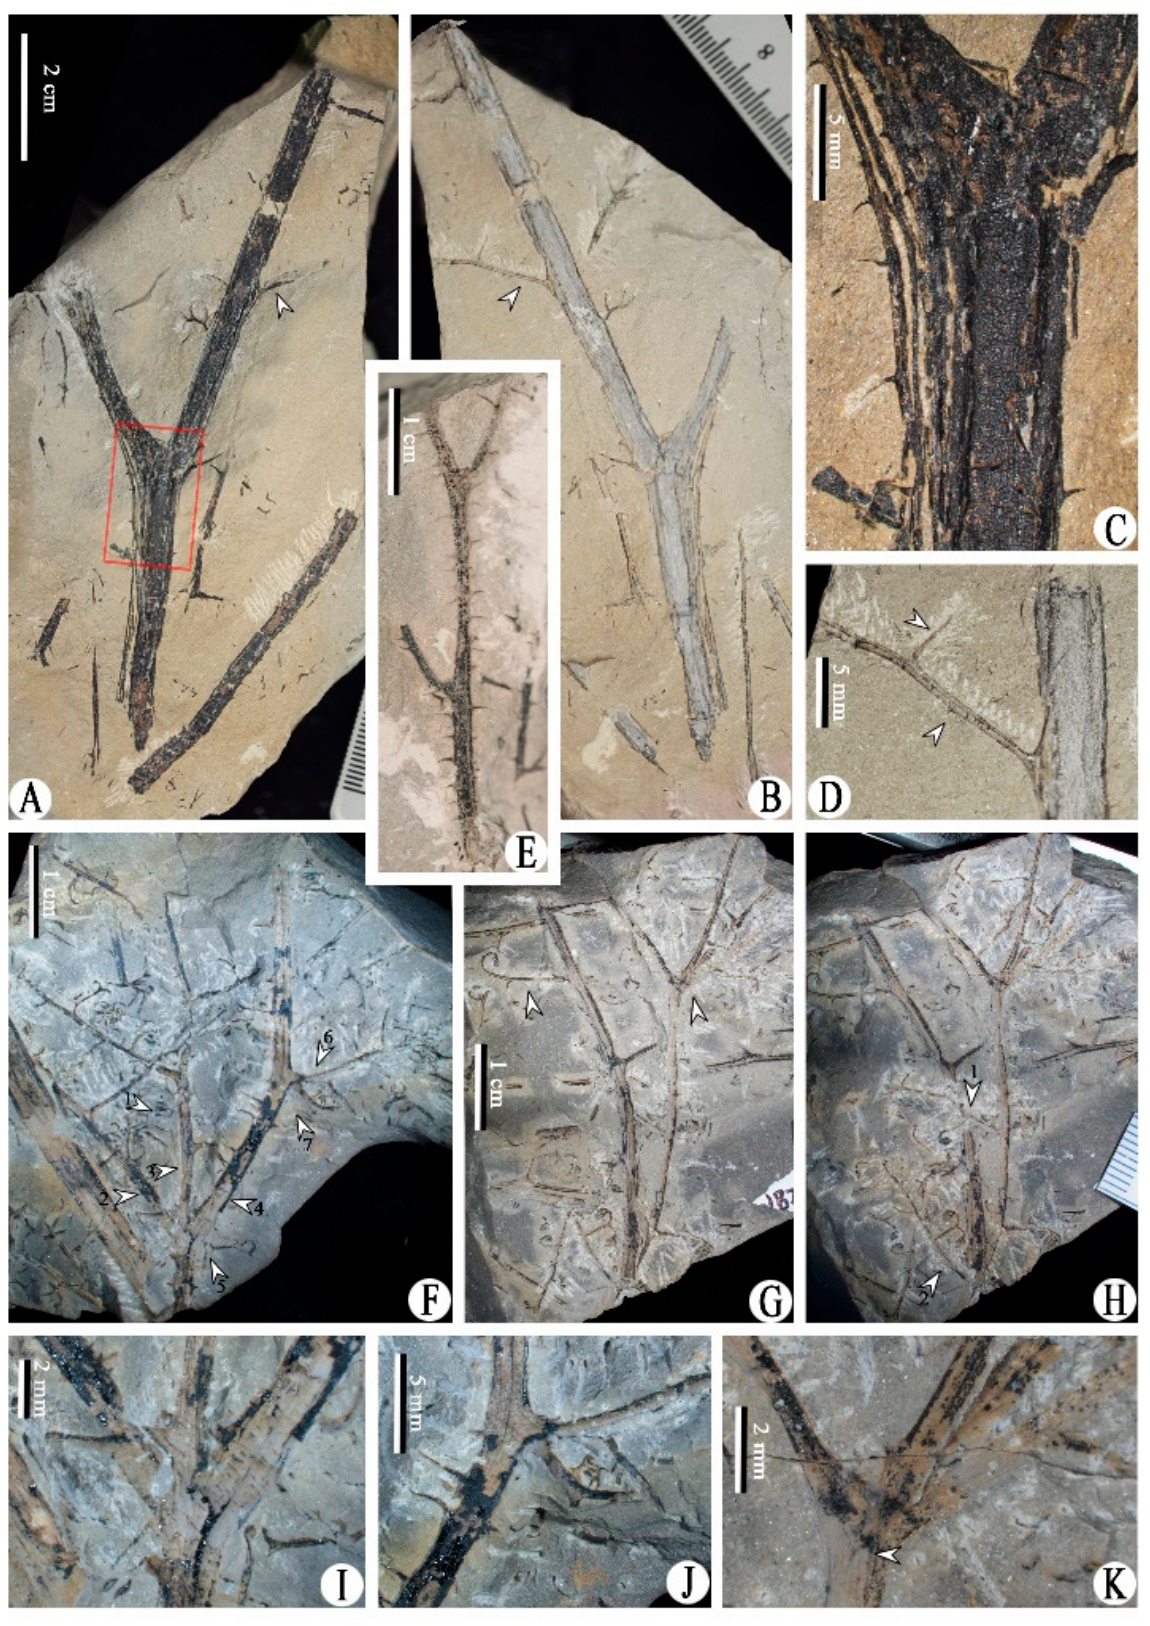
Figure 1. Morphology of Xinhangia spina gen. et sp. nov. from Guangde City, Anhui Province, China. ( A , B ) Part and counterpart of dichotomous main axis bearing one primary branch (arrow). ( C )